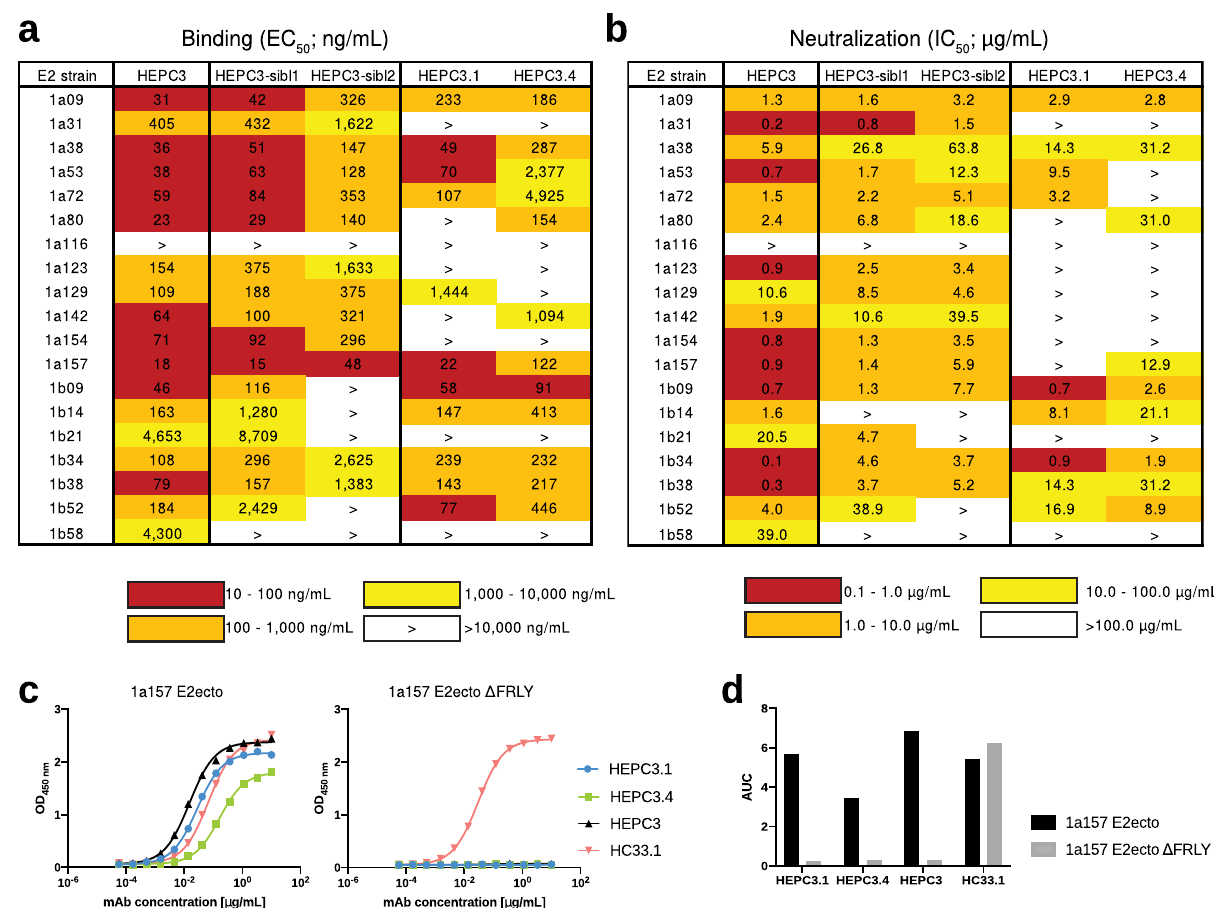
Fig. 2 HEPC3.1, HEPC3.4, and sibling HEPC3 Abs display broad binding activity and neutralize multiple HCV strains. a Heat map showing the binding of Abs to a panel of HCV genotype 1 E2 glycoproteins. The EC 50 value for each E2-Ab combination is shown, with dark red, orange, yellow, or white shading indicating high, intermediate, low, or no detectable binding, respectively. The “ > ” symbol indicates EC 50 values >10 µ g/mL or combinations were OD 450 values at the highest antibody concentration tested were lower than 0.5. One experiment representative of two independent experiments is shown. b Heat map showing neutralization activities of Abs measured using a panel of genotype 1 HCVpp. The IC 50 value for each E2-Ab combination is shown, with dark red, orange, yellow, or white shading indicating high, intermediate, low, or no detectable neutralization activity, respectively. The “ > ” symbol indicates IC 50 values >100 µ g/mL or combinations in which percent neutralization at the highest antibody concentration tested was lower than 50%. c Binding of HEPC3.1, HEPC3.4, and reference bNAbs to a 1a157 E2 glycoprotein ectodomain (1a157 E2ecto) and 1a157 E2 variant that contains alanine substitutions that disable binding of HEPC3-like bNAbs that target AR3 antigenic site (1a157 E2ecto Δ FRLY). Introduced alanine substitutions in 1a157 E2ecto Δ FRLY do not disrupt the binding of HC33.1-like bNAbs targeting the antigenic site 412 (AS412) that lies in close proximity to the E2 front layer. One experiment representative of two independent experiments is shown. Source data are provided in the Source Data fi le. d Binding data from ( c ) is shown as the area under the curve